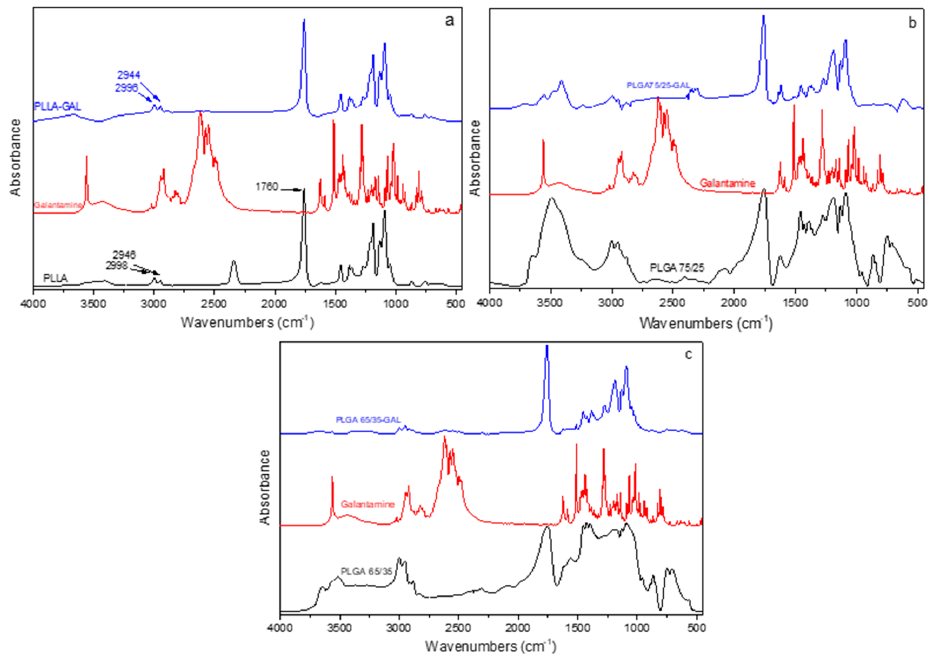
Figure 6. FT-IR spectra of neat polymers and their nanoparticles with galantamine. ( a ) PLLA–GAL, ( b ) PLGA 75/25–GAL, and ( c ) PLGA 65/35–GAL.